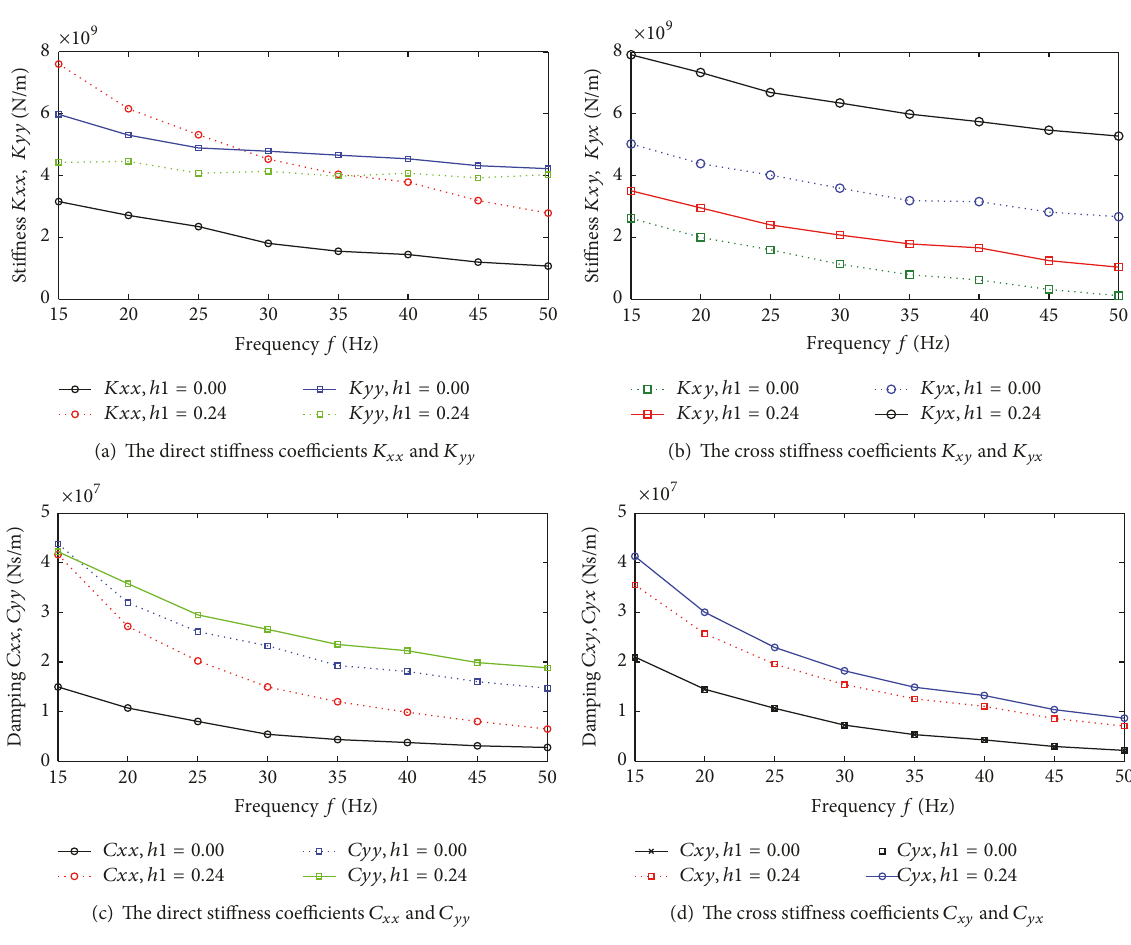
(b) The cross stiffness coefficients 𝐾 𝑥𝑦 and 𝐾 𝑦𝑥